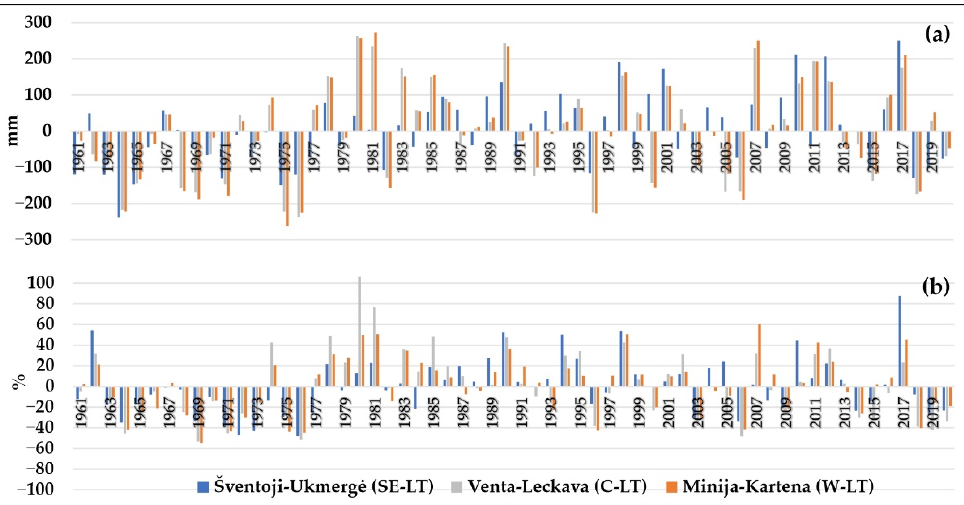
Figure 2. ( a ) Deviations from the average amount of precipitation (in mm); ( b ) Deviations from the average amount of discharge (in %).